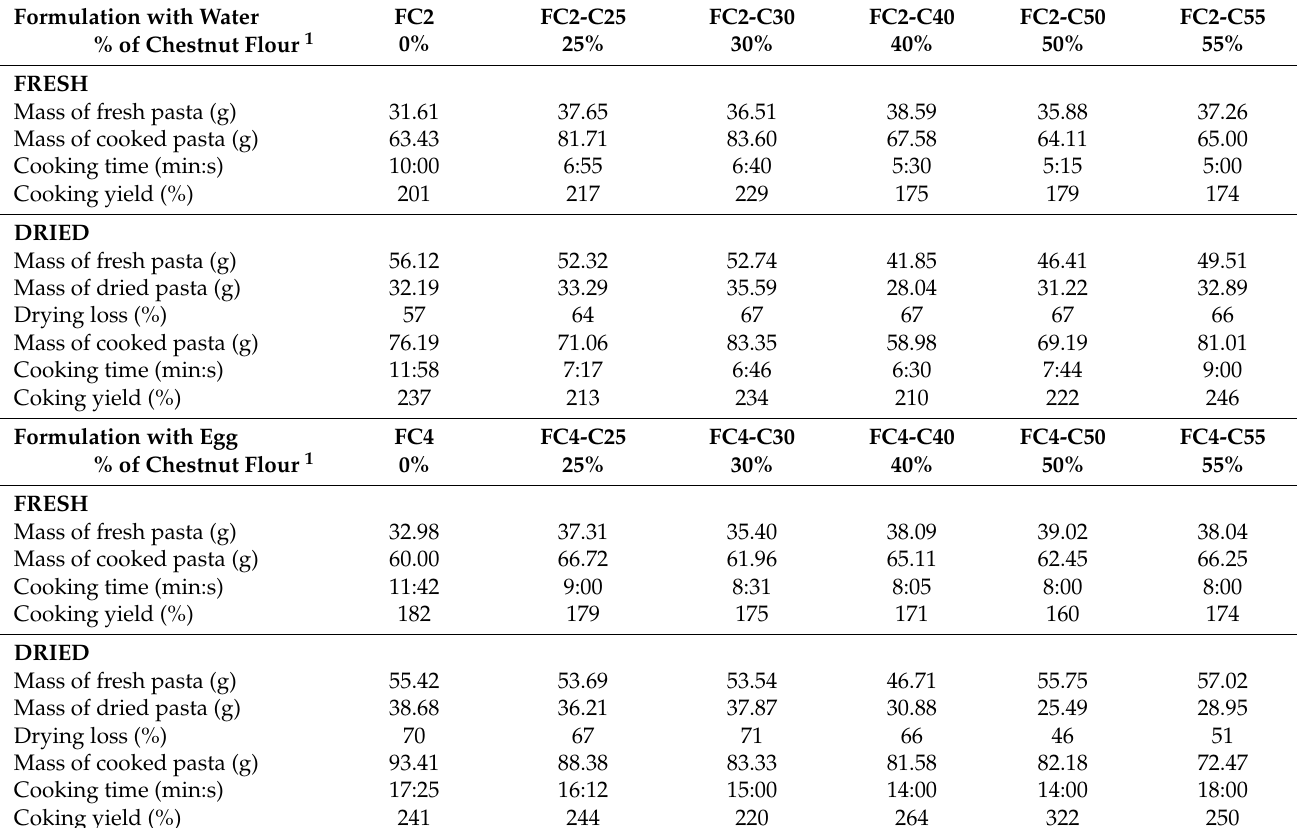
Table 5. Experiments for pasta containing water or egg plus chestnut flour at variable